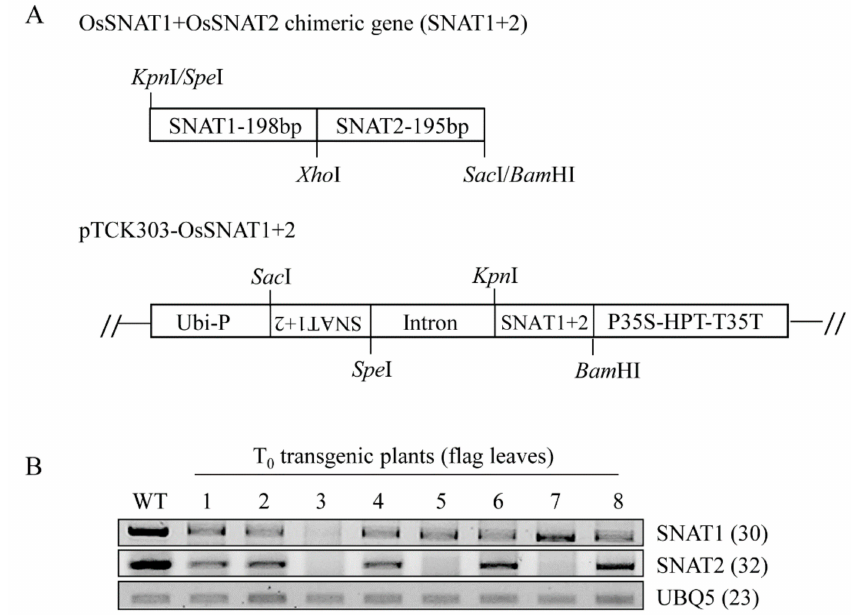
Figure 1. Schematic diagram of the SNAT1 + 2 chimeric gene construct and reverse transcription–polymerasechainreaction(RT-PCR)analysesofT 0 transgenicriceplants. ( A )Construction of chimeric gene containing SNAT1 and SNAT2 and the binary vector used for SNAT1 + 2 suppression. ( B ) RT-PCR analyses of independent T 0 transgenic lines grown for 15 weeks in a paddy field. SNAT = serotonin N -acetyltransferase, Ubi-P = maize ubiquitin promoter, HPT = hygromycin phosphotransferase, WT = wild-type, UBQ5 = riceubiquitin5gene, and1–8 = SNAT1 + 2 -underexpression line. The GenBank accession numbers of SNAT1, SNAT2, and UBQ5 are AK059369,